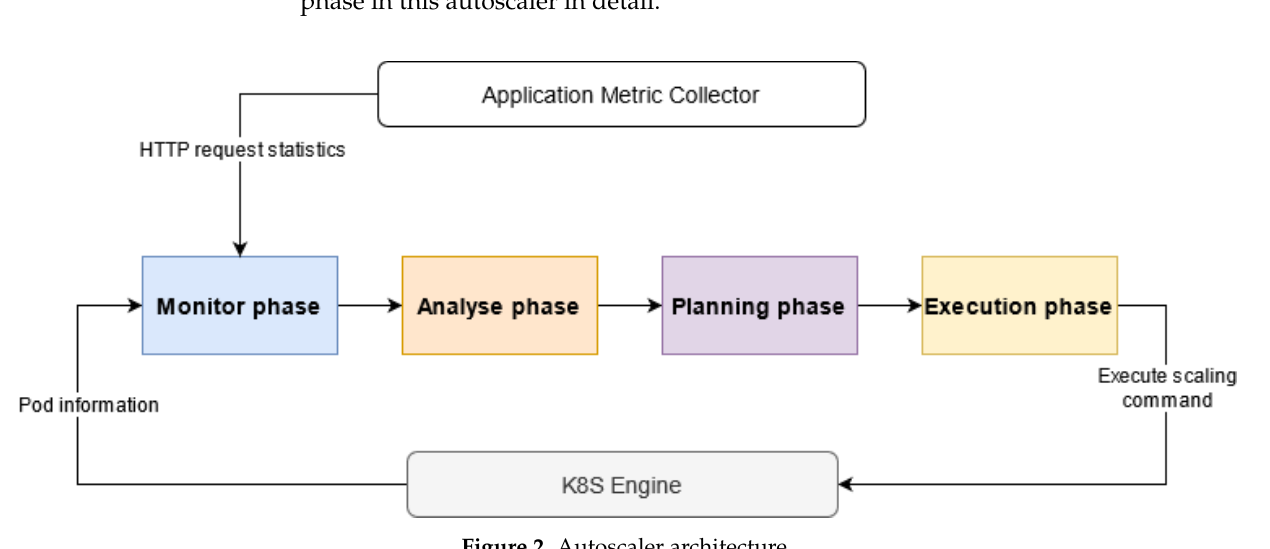
Figure 2. Autoscaler